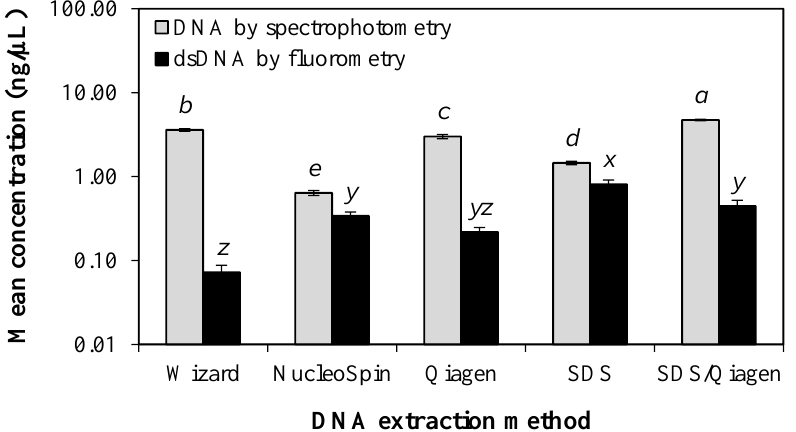
Figure 1. Mean DNA and dsDNA concentrations of EBN samples extracted with five different DNA extraction methods as measured by spectrophotometry and fluorometry, respectively. Different letters in each quantification method indicate significant differences ( p < 0.05). Values are mean ± standard error with samples size n = 52 (spectrophotometry) and n = 13 (fluorometry).